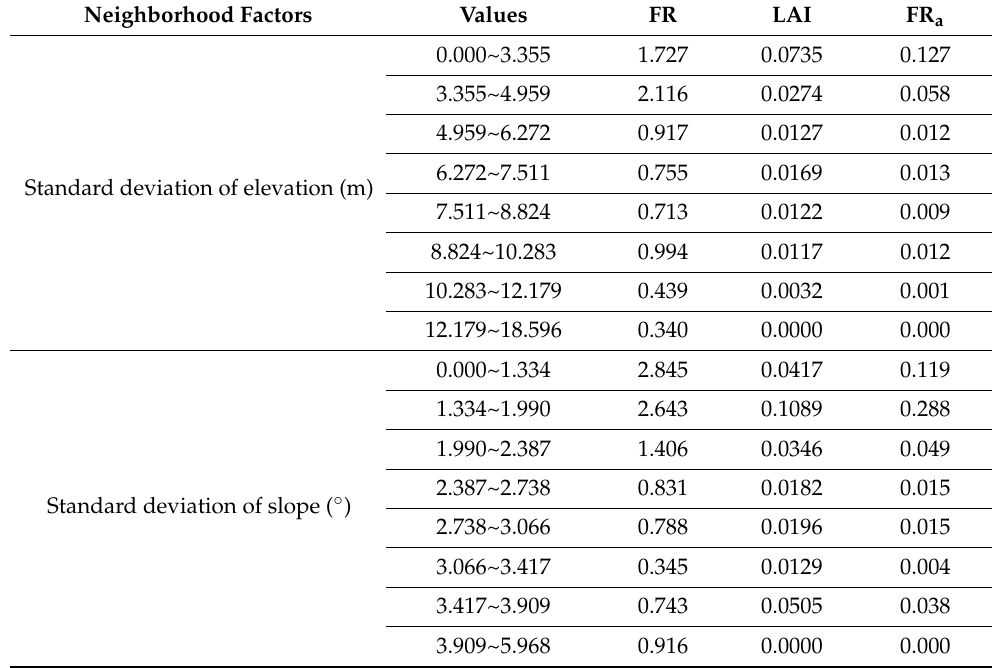
Table 2. FR values considering neighborhood environmental factors (some factors are not shown). Neighborhood